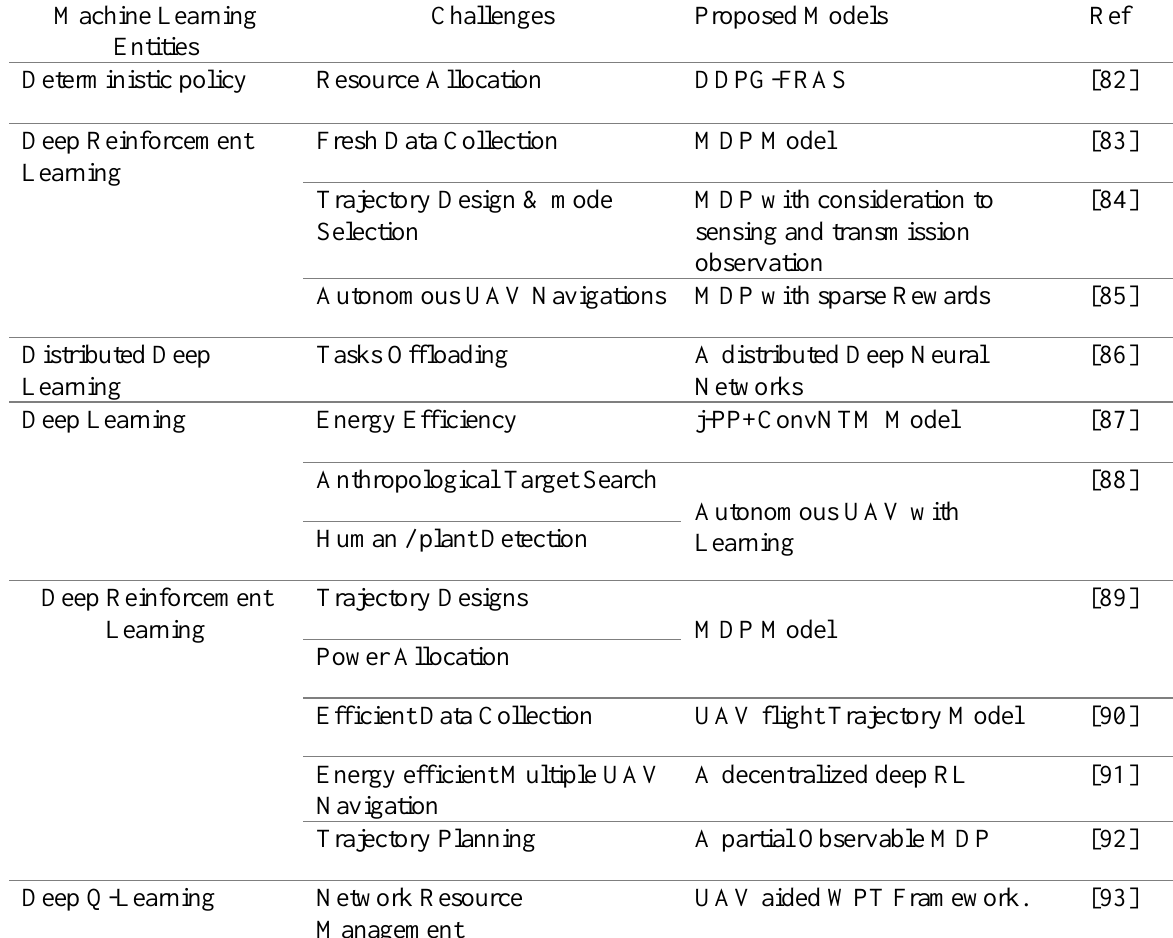
Table 2. A summarized challenge of UAV and state-of-the-art proposed